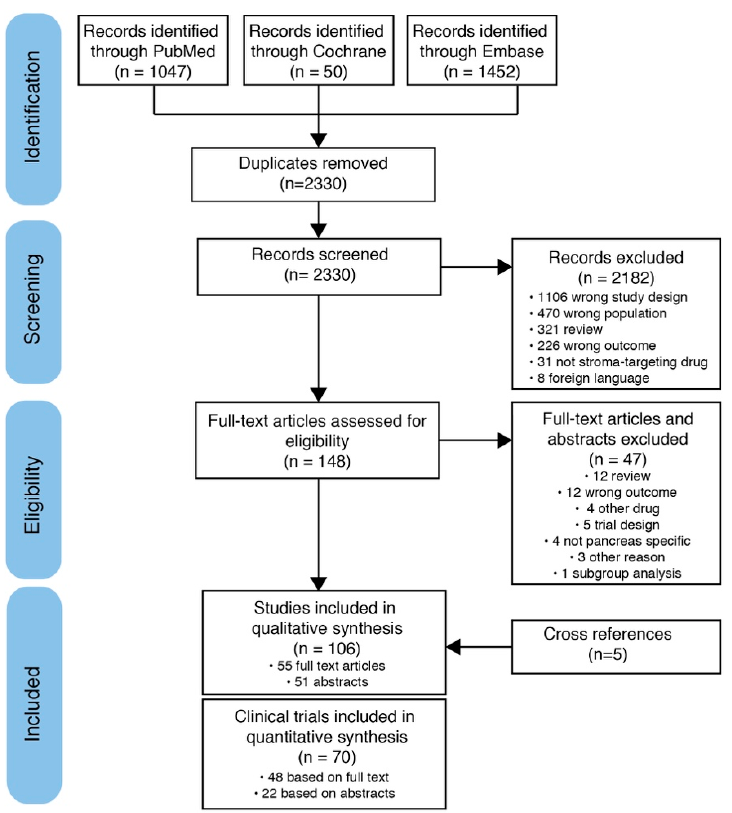
Figure 2. Flow chart of included articles according to the Preferred Reporting Items for Systematic Reviews and Meta-Analyses (PRISMA) statement [113].